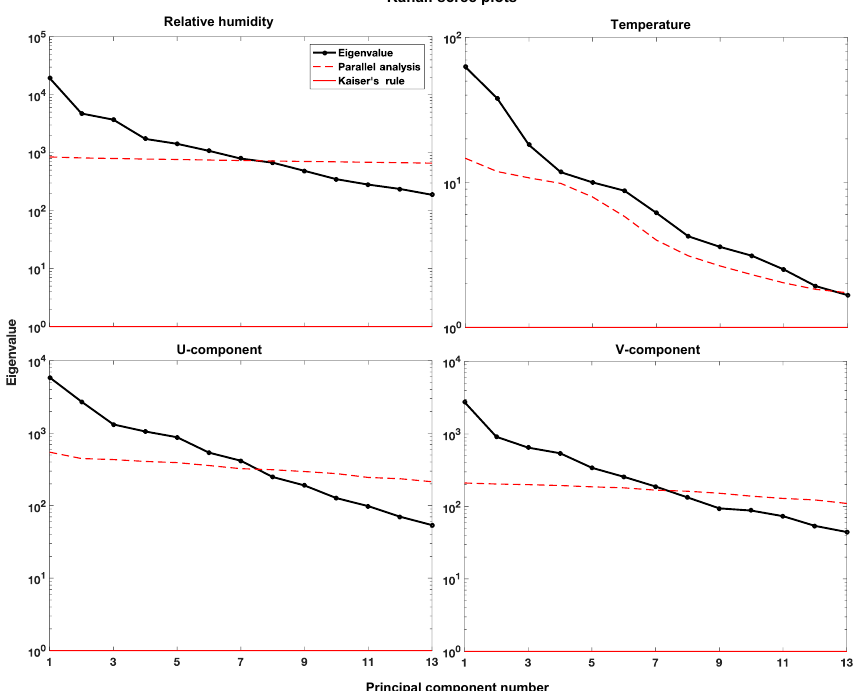
Figure 4. Scree plots for the Ranai upper-air sounding site for the four variables of interest. The calculated eigenvalues are in black and the PC retention criteria are in red. Generally, Kaiser’s rule (solid red) overestimates the number of PCs to retain, whereas Horn’s parallel analysis (dashed red) is more